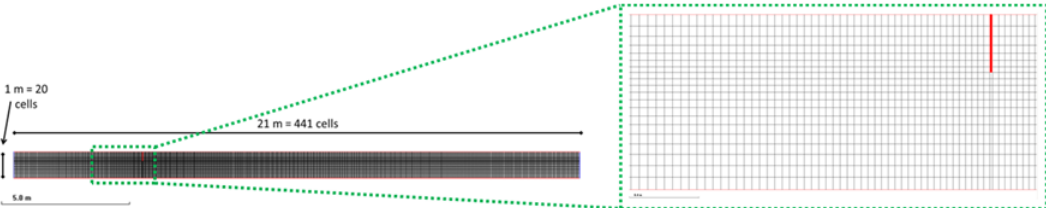
Figure 5. Sketch of the computation grid.